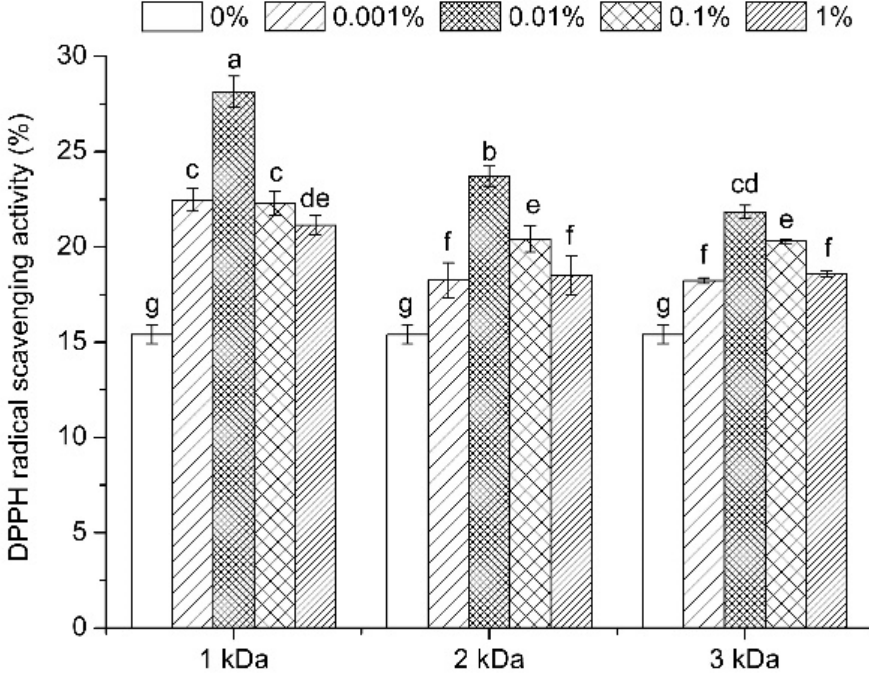
Figure 4. DPPH radical scavenging activity of soybean sprouts under different chitooligosaccharide treatments. The treatments were conducted with chitooligosaccharides of three molecular weights (1, 2, and 3 kDa) at four different concentrations (0.001 to 1%). The control treatment (0%) included the same solutions without chitooligosaccharides. Vertical bars represent the standard error of three replicates. Different letters indicate statistically significant difference ( p < 0.05).